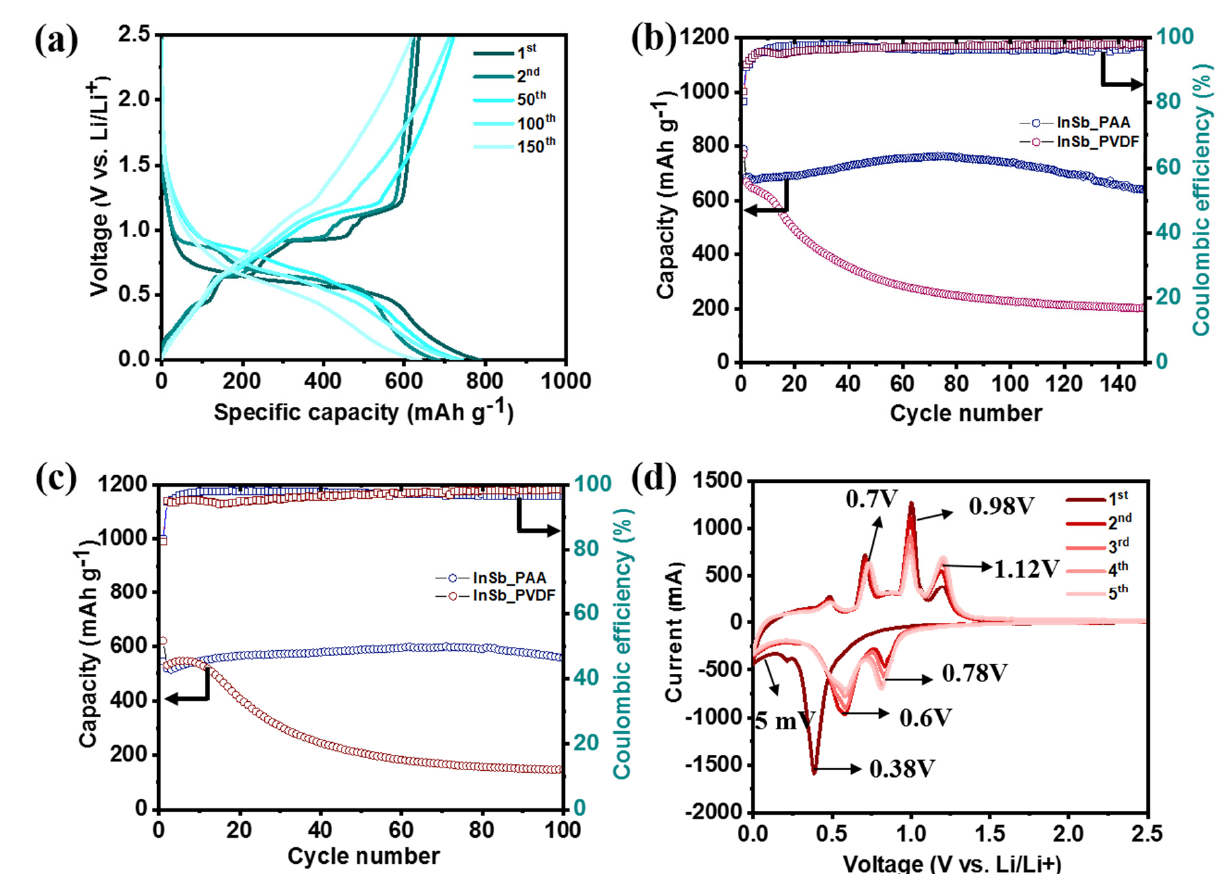
Figure 2. Electrochemical performance of the InSb electrode. ( a ) GCD voltage profiles of InSb_PAA at a current density of 100 mA · g − 1 . Cyclic performance of the InSb_PAA and InSb_PVDF at a current density of ( b ) 100 and ( c ) 500 mA · g − 1 . ( d ) CV curves of InSb_PAA.